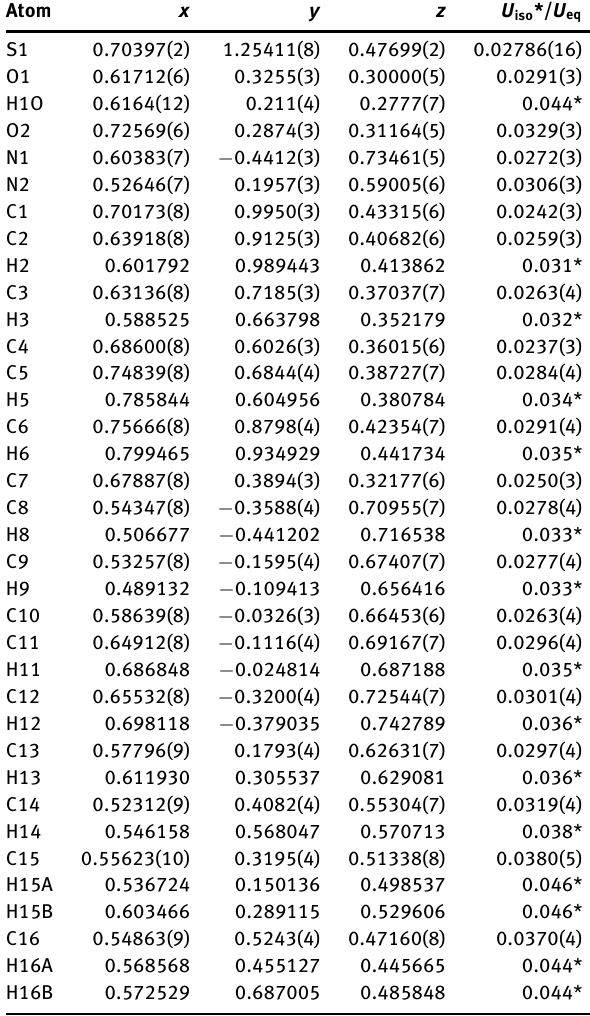
Table 2: Fractional atomic coordinates and isotropic or equivalent isotropic displacement parameters (Å 2